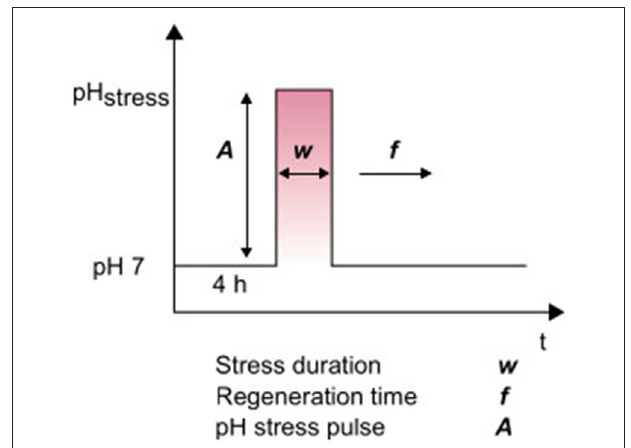
FIGURE 1 | Overview of parameters for dynamically controlled pH